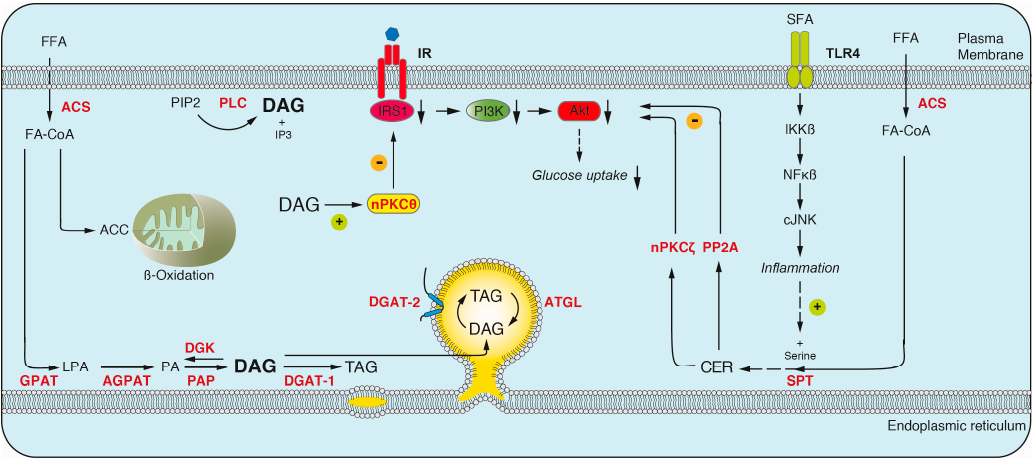
Figure 5. Lipid intermediates and their interactions with insulin signaling pathways in muscle. Free fatty acids (FFA) are transported into the cell, activated by acyl-CoA-synthase (ACS), and channeled into different pathways: (i) TAG synthesis occurs in four sequential reactions, catalyzed by members of the glycerol-3-phosphate-o-acyltransferase (GPAT), 1-acylglycerol-3-phosphate (AGPAT), phosphatidic acid phosphatase (PAP) and diacylglycerolacyl-transferase (DGAT) enzyme families in the ER and/or LDs. DAG, a key intermediate in TAG synthesis, can alternatively be generated by stimulus-dependent cleavage of phosphatidylinositol 4,5-bisphosphate (PIP2) by phospholipase C (PLC) at the plasma membrane. The lipolysis of TAG by adipose triacylglycerol lipase (ATGL) generates DAG on LDs. Accumulated DAG species recruit and activate nPKC θ which leads to inhibitory phosphorylation of IRS1, downregulation of phosphatidylinositol-kinase 3 (PI3K), AKT and ultimately glucose uptake (indicated by downward arrows); (ii) FA-CoAs are converted to acylcarnitines (ACC) for shuttling and subsequent β -oxidation in mitochondria. Decreased or incomplete oxidation leads to their accumulation and affects insulin sensitivity; (iii) Ceramide synthesis is initiated by serine palmitoyl transferase (SPT) in the ER. Binding of saturated FA (SFA) to toll-like receptor 4 (TLR4) induces an inflammatory response, contributing to increased ceramide synthesis. Ceramides inhibit insulin signaling by decreasing the activity of AKT via protein phosphatase 2A (PP2A) or atypical PKC ζ . Lysophosphatidic acid (LPA); Phosphatidic acid (PA); Diacylglycerol kinase (DGK); Inositol-1,4,5-Trisphosphate (IP3).